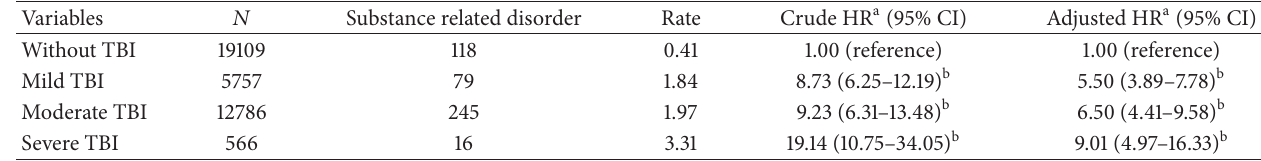
Table 4: Incidence and hazard ratios for substance related disorder stratified by the severity of TBI. Variables